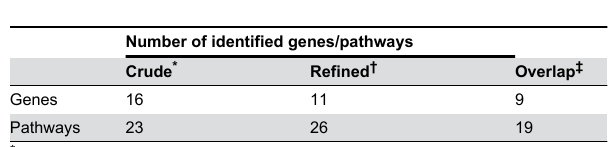
Table 3. Comparison of the results in the enrichment analyses between the crude and refined dataset.